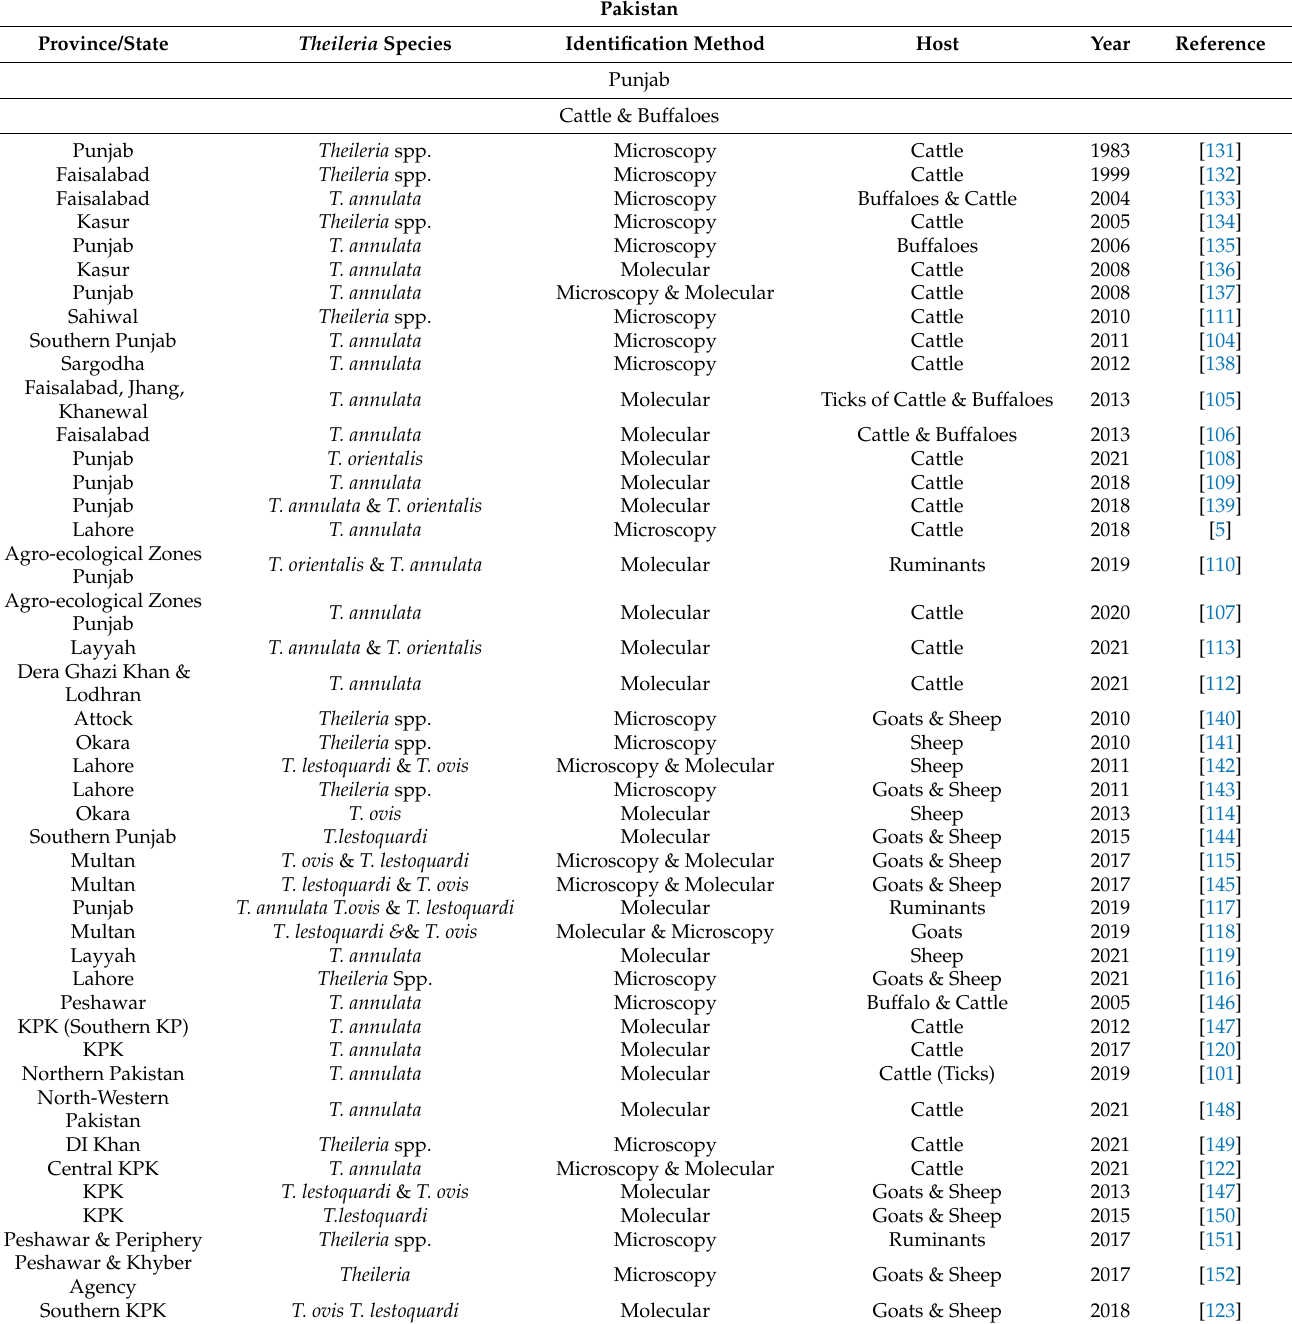
Table 4. Provincial wise distribution of the different Theileria species in Pakistan.